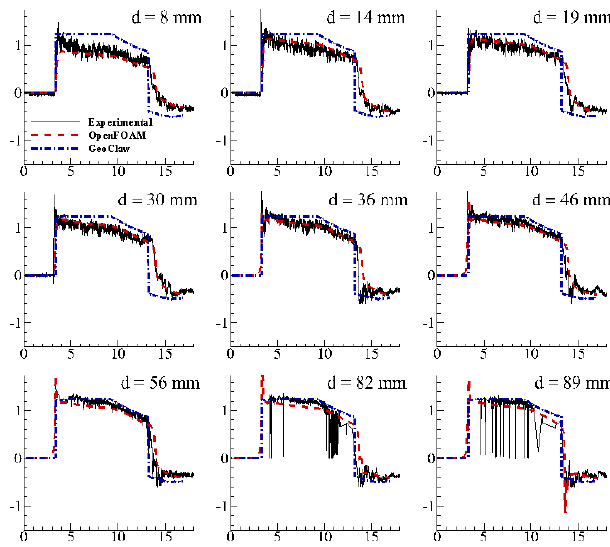
Figure 3. Time history of streamwise velocity at different distances, d , from the bottom at 5 . 2m from the gate (center of the column) with the column removed. Abscissa: time (s). Ordinate: velocity (ms − 1 ).